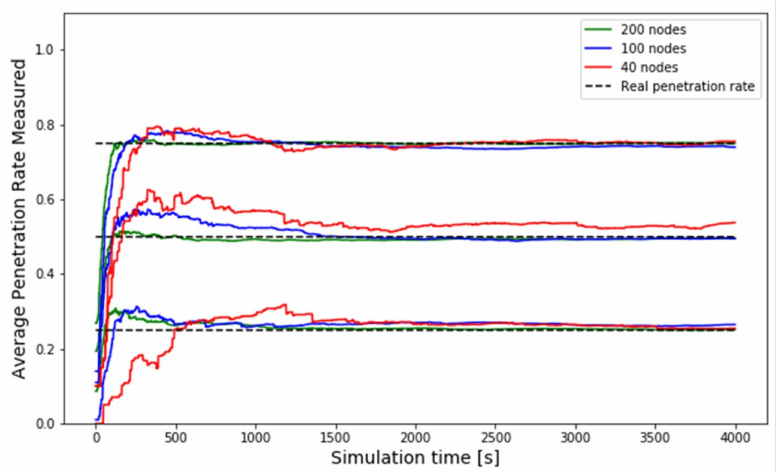
Figure 4. Average geocast group penetration rate measured by